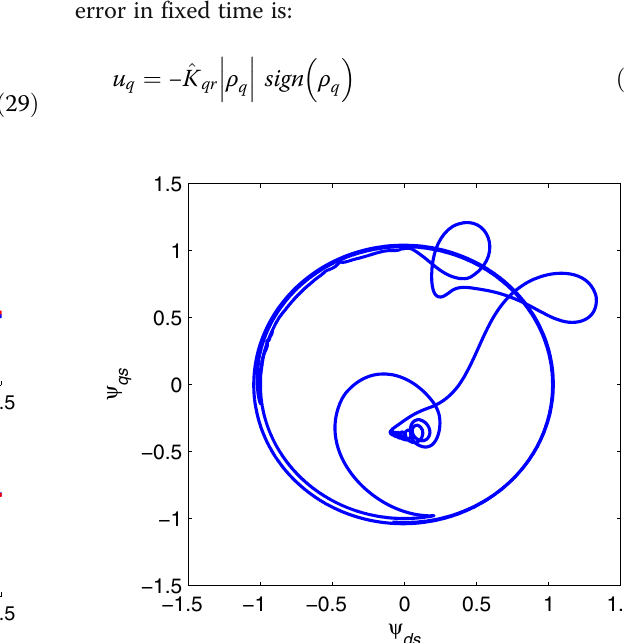
Fig. 10 Stator flux